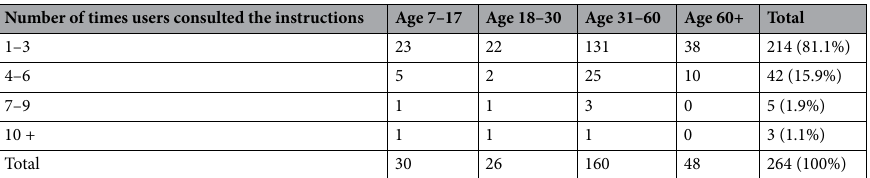
Number of times users consulted the instructions